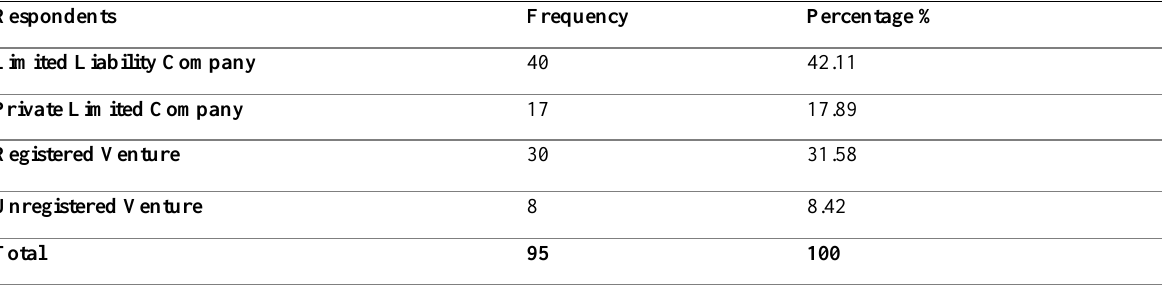
Table 3: Analysis based On Nature of